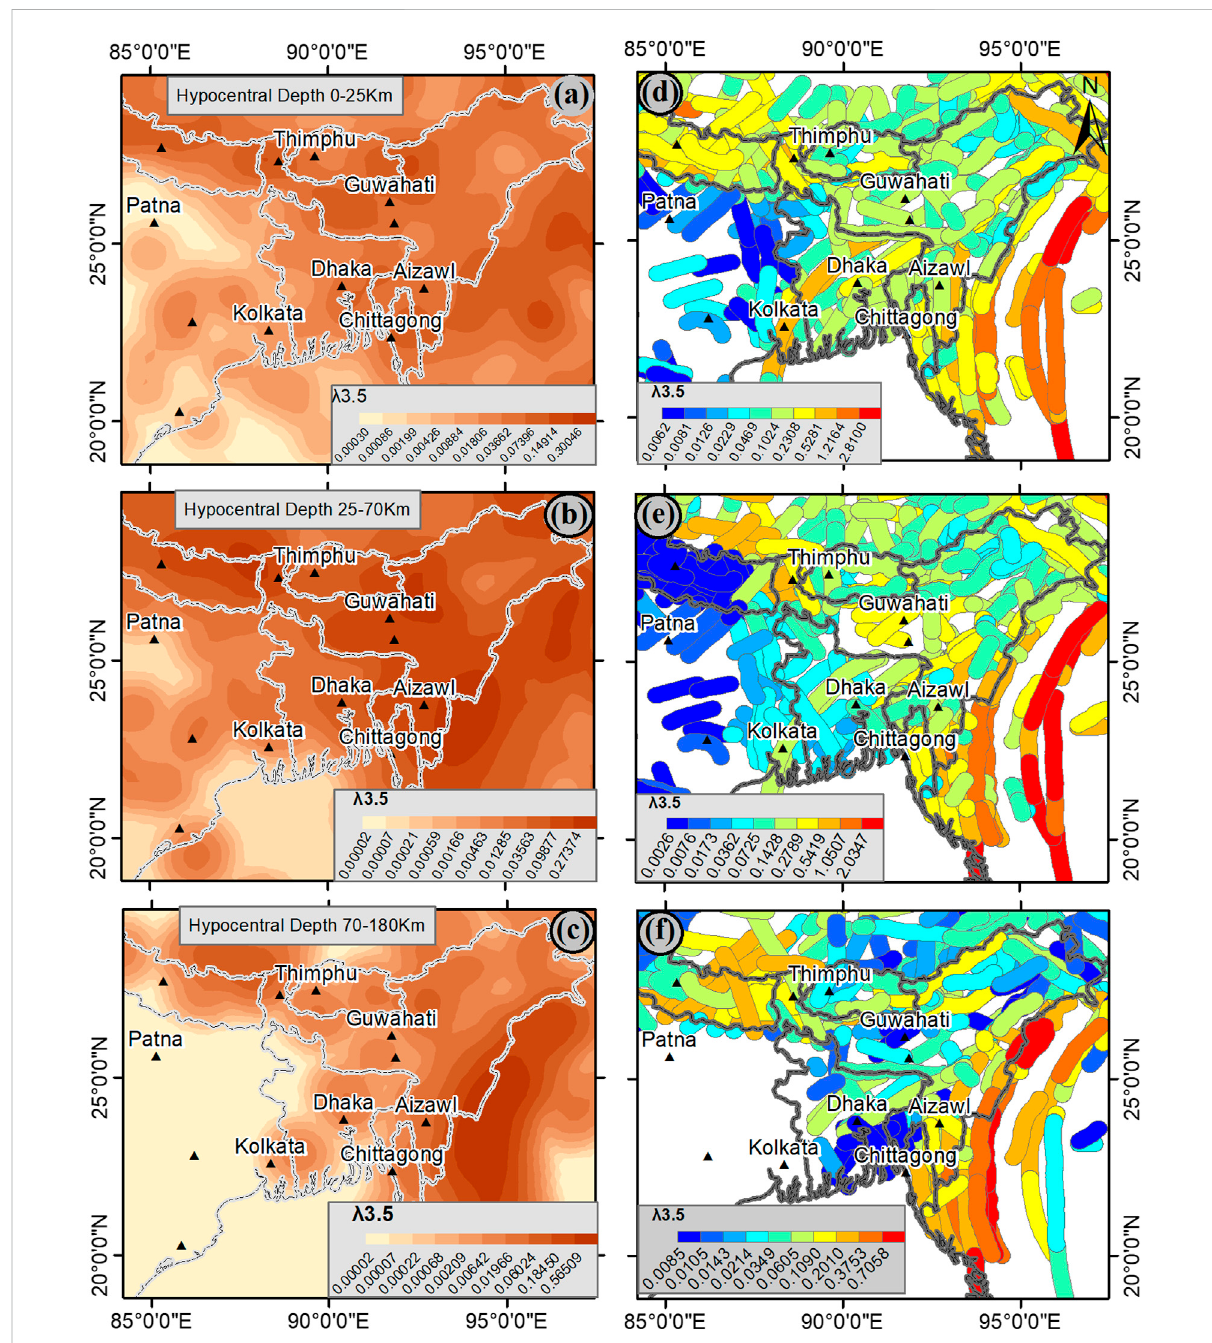
FIGURE 3 Representative smoothened seismicity model for the layered polygonal seismogenic sources for the threshold magnitude of M W 3.5 for the hypocentral depth ranges of (A) 0 – 25 km, (B) 25 – 70 km, and (C) 70 – 180 km and annual activity rate of each tectonic feature inscribed in the areal seismogenicsources for the thresholdmagnitudes M W 3.5 at the three hypocentral depth ranges of (D) 0 – 25 km, (E) 25 – 70 km, and (F) 70 – 180